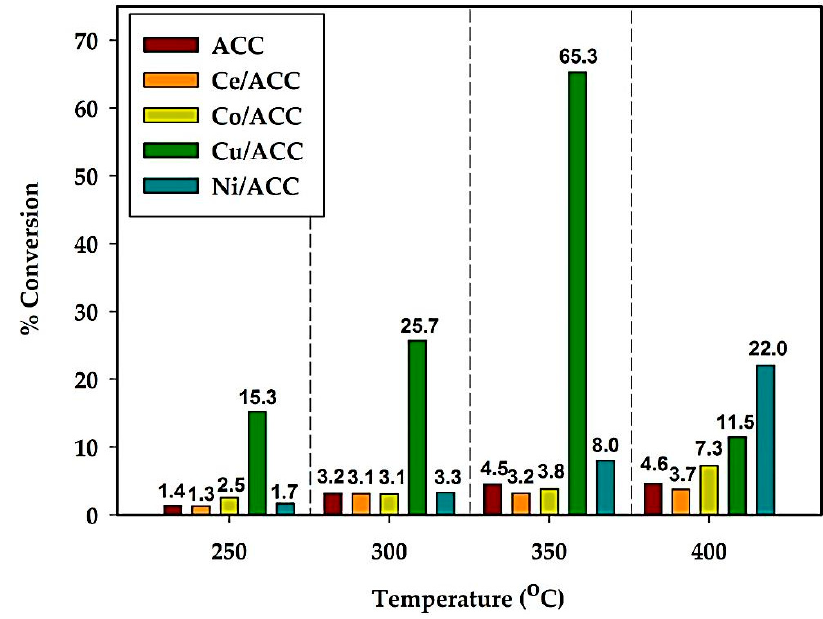
Figure 6. Ethanol conversion of catalysts.